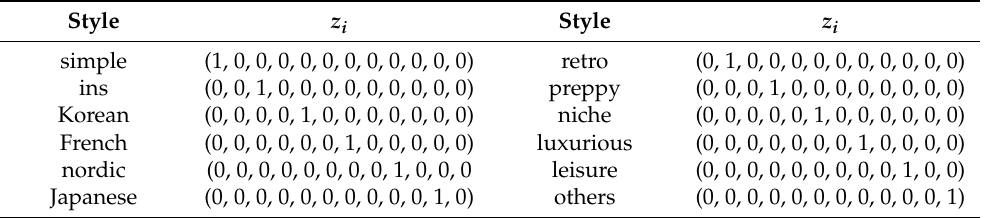
Table 3. Style one-hot encoding